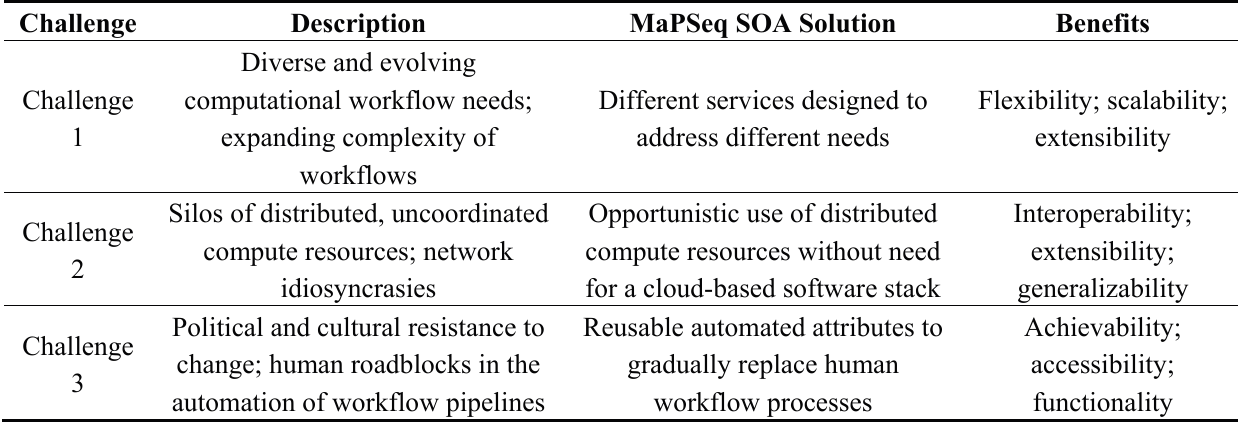
Table 1. An overview of the challenges that contributed to the architectural design of